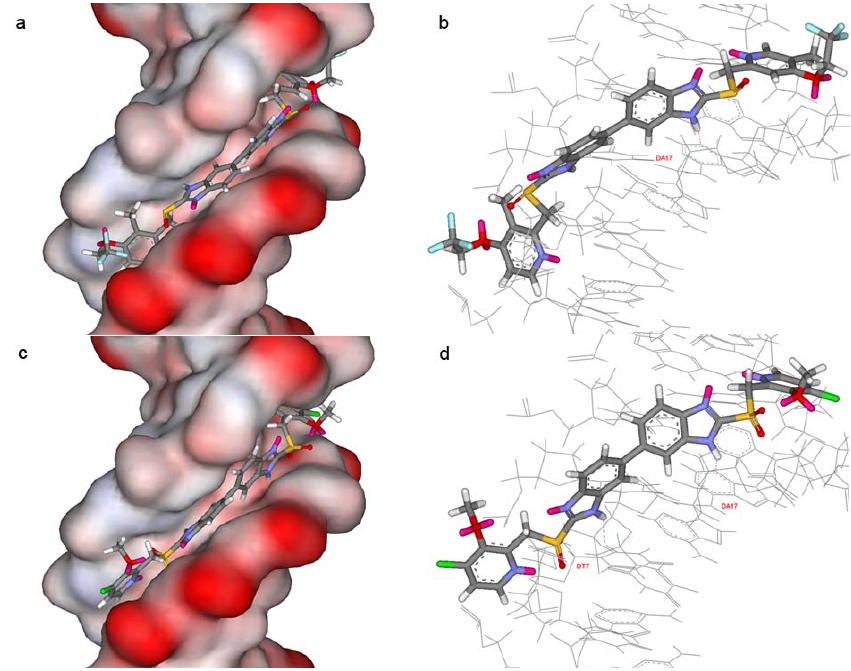
Figure 2 . Two views of the binding to the sequence d(CGCAAATTTGCG) of compounds 3c and 4d , respectively. (a) Close-up view of compound 3c binding in the minor groove, highlighting the electrostatic potential surface of the oligonucleotide. (b) Close-up view of hydrogen bonds between compound 3c and the DNA minor groove. (c) Close-up view of compound 4d binding in the minor groove, highlighting the electrostatic potential surface of the oligonucleotide. (d) Close-up view of hydrogen bonds between compound 4d and the DNA minor